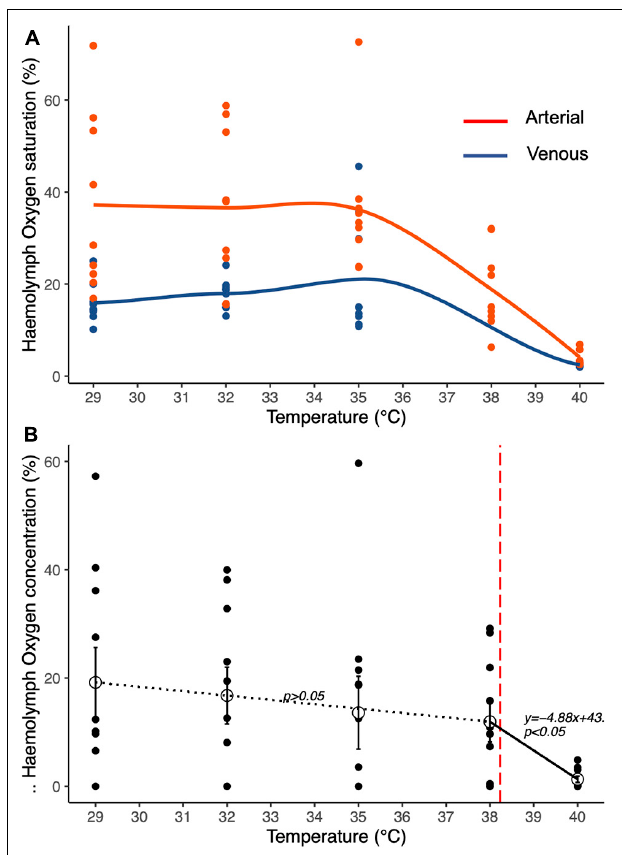
FIGURE 4 | Temperature-dependent haemolymph dissolved oxygen content of T. crenata during (A) water respiration at 100% oxygen saturation; red circles arterial haemolymph, blue circles venous haemolymph. (B) the arterio-venous differences in PO 2 provide an indication of the relative efficiency of respiration in water. The dotted line indicates a non-significant relationship between temperature and haemolymph dissolved oxygen content, while the solid line indicates a significant reduction of haemolymph dissolved oxygen content with increasing temperatures after the estimated breakpoint at 38.23 ◦ C indicated by the vertical red dashed